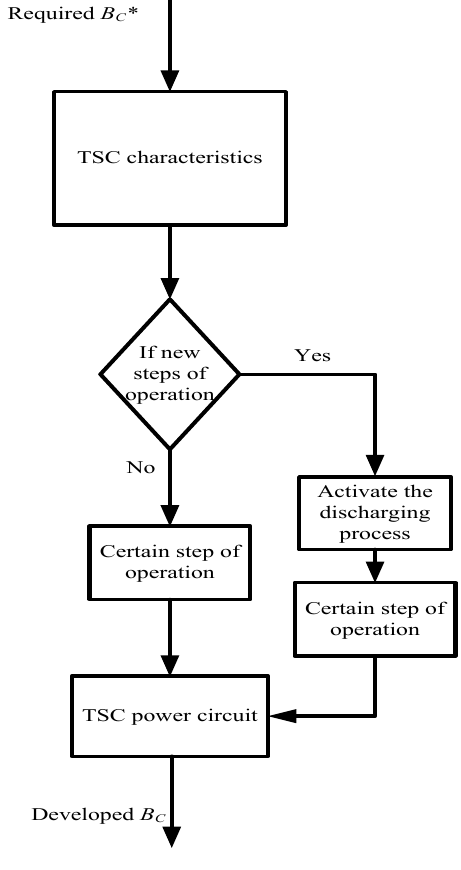
Fig. 8. Flow chart of algorithms for controlling thyristors switched